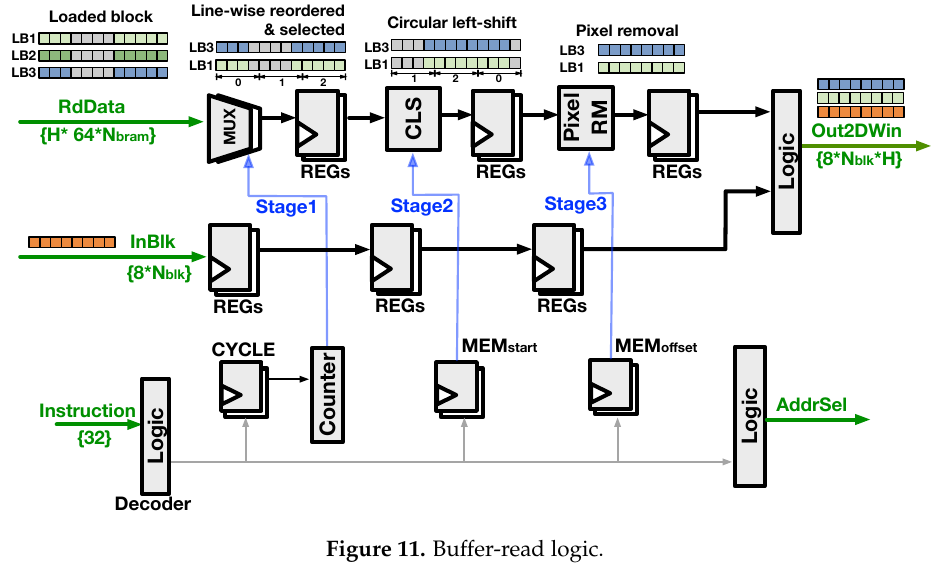
Figure 11. Buffer-read